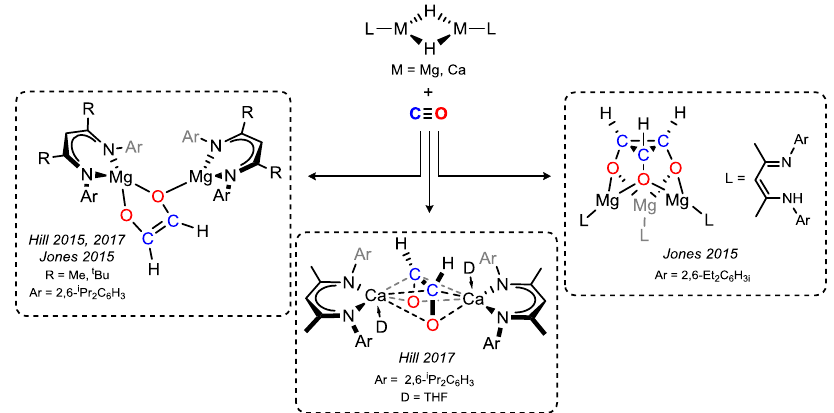
Fig. 1 CO-dimerisation and -trimerisation through metalation with Alkaline Earth hydride complexes. Reaction of molecular magnesium and calcium hydride complexes has led to either CO-dimerisation, forming the ethenediolate moiety, or trimerisation, forming the cyclopropanetriolate